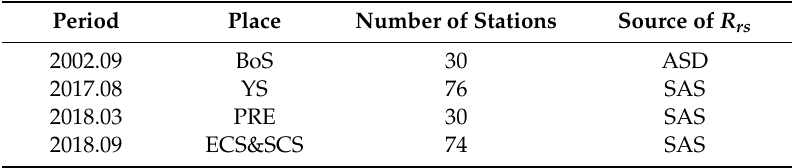
Figure 2. CV( 𝑅 (cid:3045)(cid:3046) ) for all stations